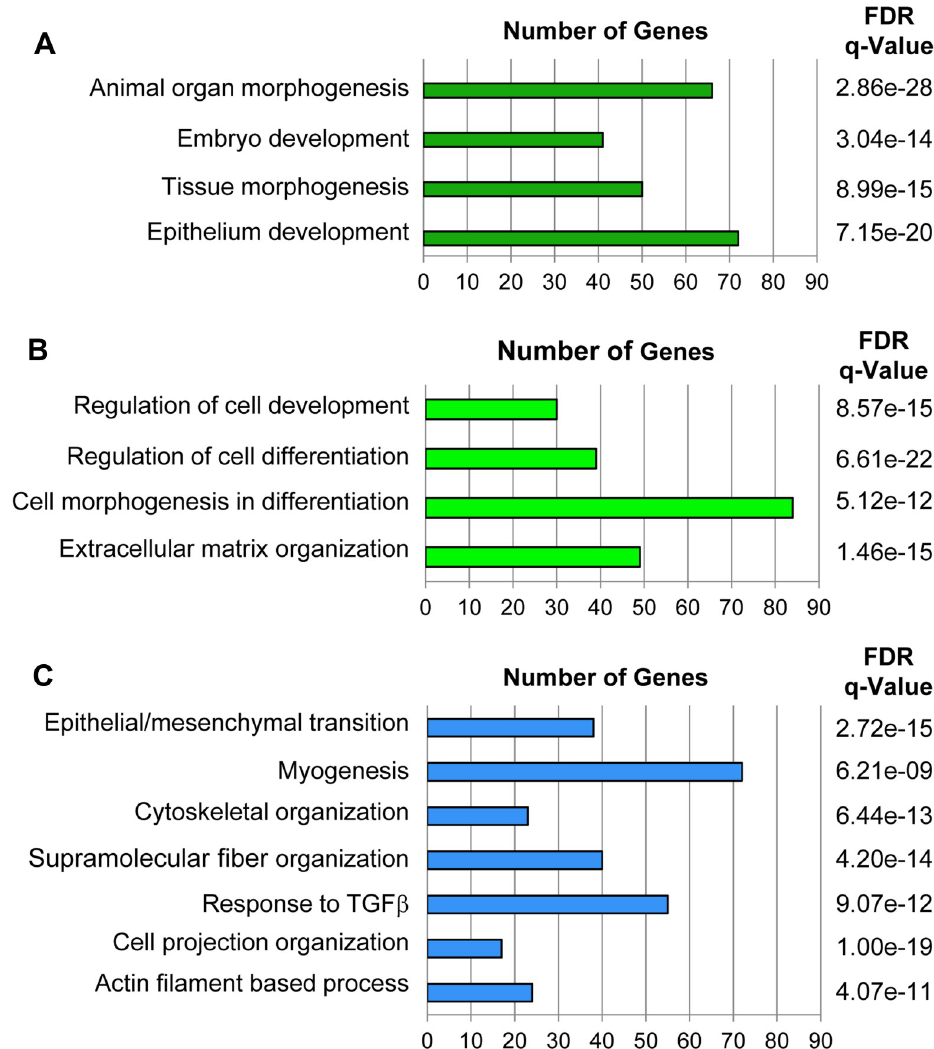
Fig 3. Genes upregulated in mSG-PAC1 spheroids cultured in Pro-M medium are associated with processes involved in myoepithelial differentiation. Gene microarrays were performed on RNA isolated from mSG-PAC1 spheroids cultured either in Pro-A or Pro-M medium. N = 3 independent experiments. The top 500 genes most highly expressed by spheroids cultured in the Pro-M medium compared to those expressed in Pro-A M were used to compute overlap with hallmark and curated gene sets from Molecular Signatures Database (MSigDB) from the Broad institute. Genes more highly expressed in the Pro-M conditions are associated with (A) tissue, (B) cellular, and (C) myoepithelial developmental